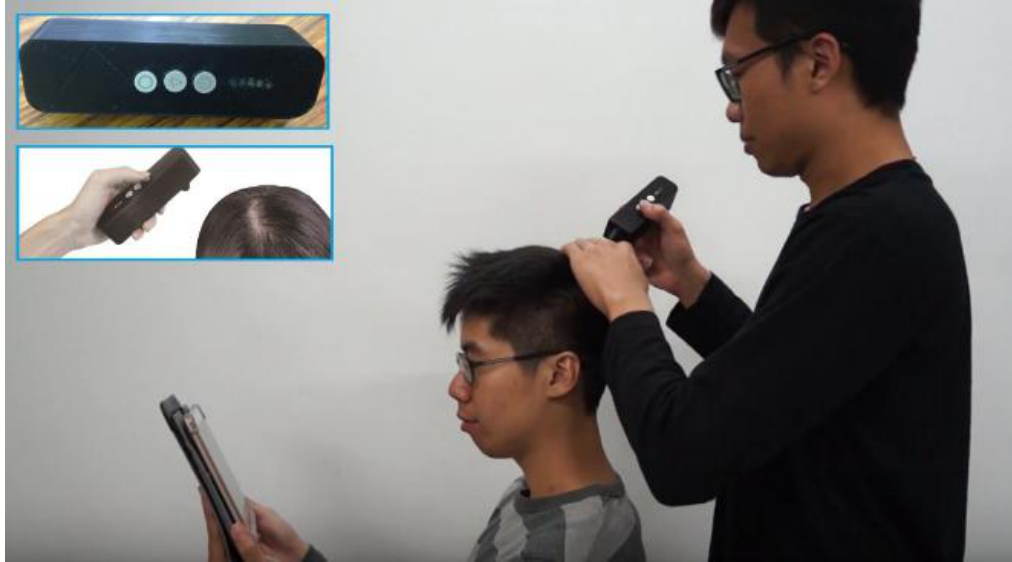
Figure 19. Taking scalp images using a 200× magnification camera.